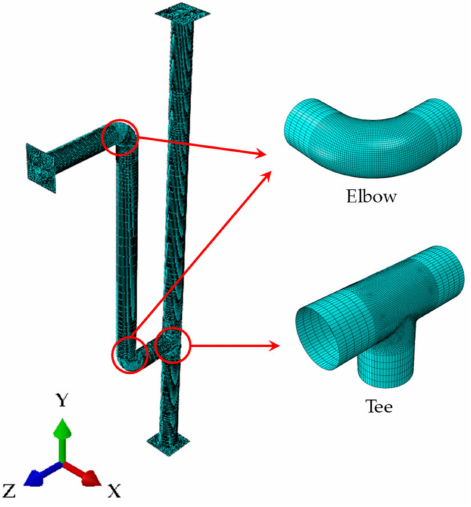
Figure 9. High fidelity FE model of large-scale press-to-connect piping